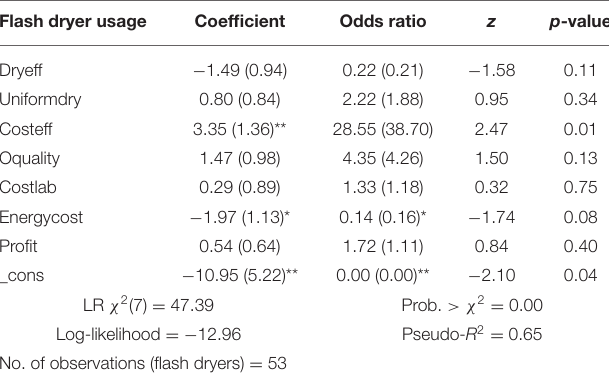
TABLE 4 | Logistic regression estimation of flash dryer usage with reference to users’ perceptions.